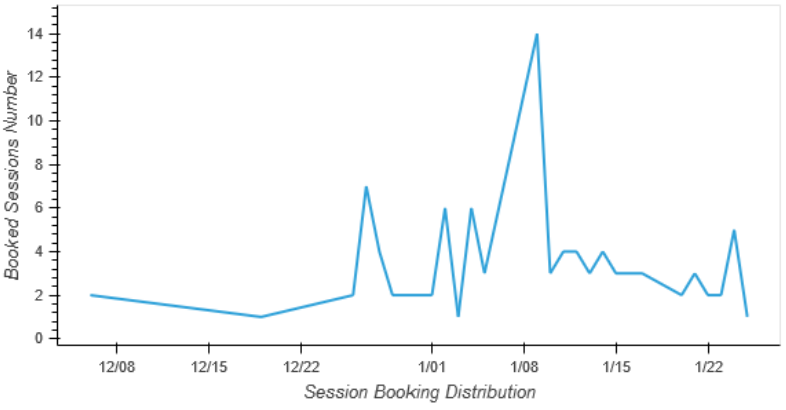
Figure 6. Evolution of the Booking Distribution.